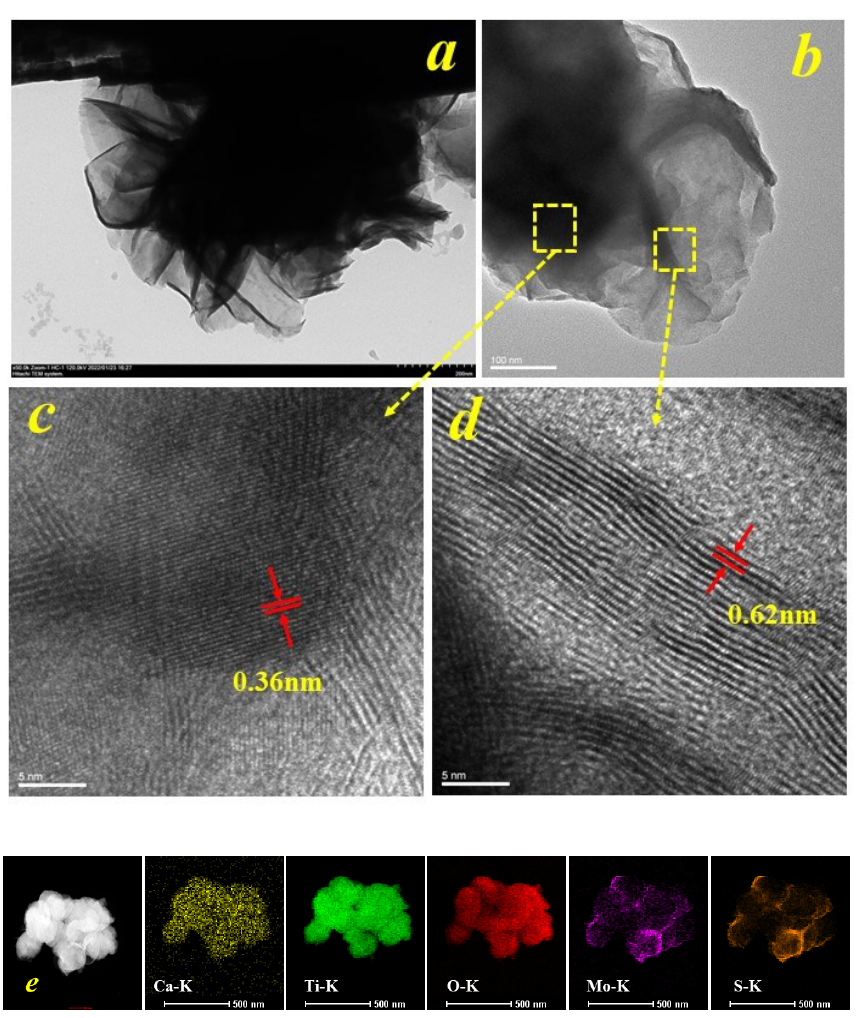
Figure 3. TEM of the MoS 2 modified CTO (MCTO-2), ( a ) TEM of the MCTO-2, ( b ) interface of the MCTO-2, ( c ) HRTEM of the CTO, ( d ) HRTEM of the MoS 2 , and ( e ) HAADF and EDS mapping images of the MCTO-2.